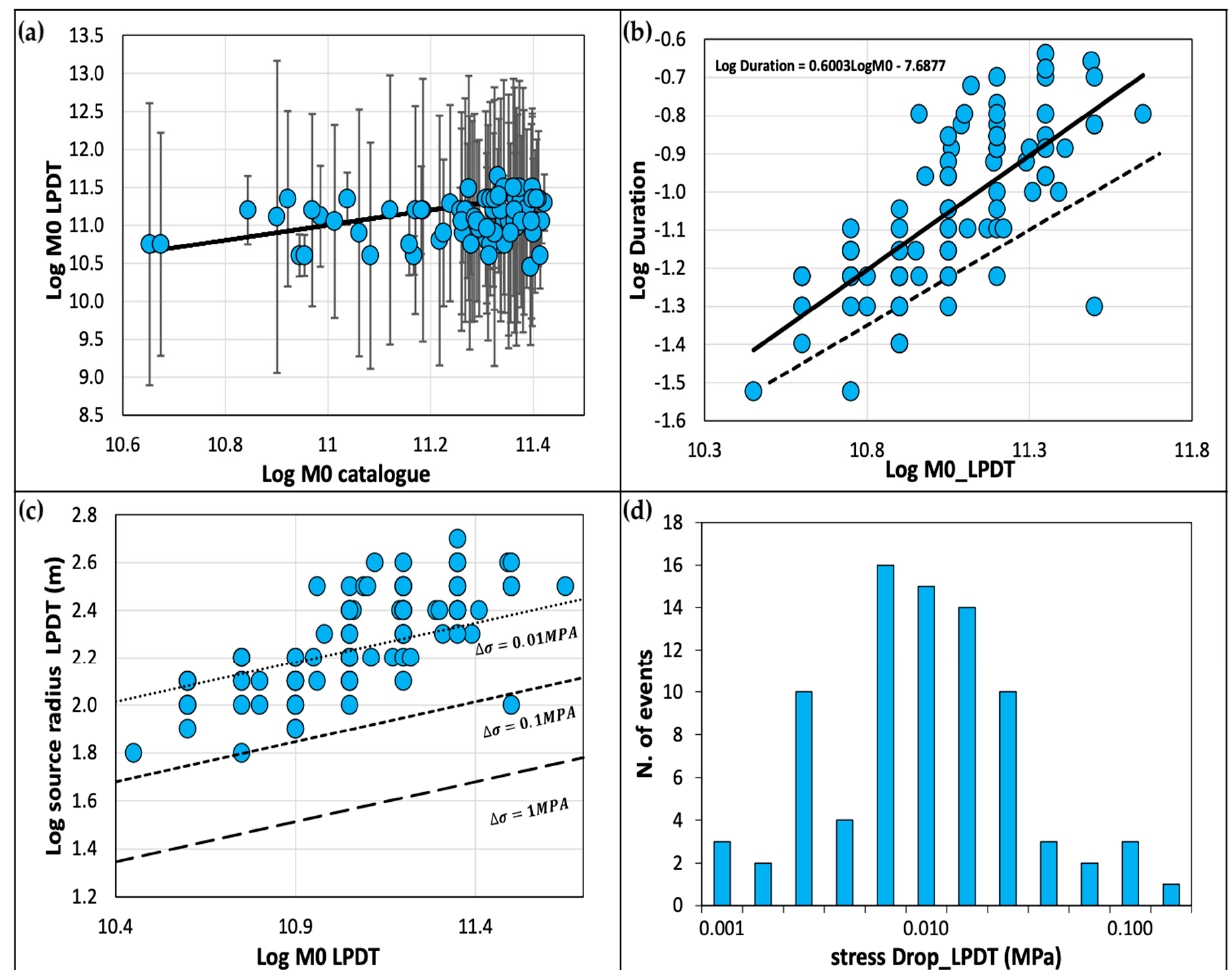
Figure 3. ( a ) Logarithm of seismic moments obtained from LPDT versus logarithm of seismic moments available from Kwiatek et al.’s refined catalogue. The solid black line represents the one-to-one relationship of catalogue M 0 . The errors are obtained by error propagation from T c and PL; ( b ) Logarithm of duration (inferred by T c of LPDT curves) versus logarithm of M 0 from LPDT. The solid black line of best fit is represented with its equation written in the top left corner of the panel; the dashed line represents the theoretical line with a slope value of 0.5 (see also Figure 4c [24]); ( c ) Logarithm of source radius versus logarithm of M 0 from LPDT. The data show a constant stress drop scaling with an average value of 0.01 MPa. Following different line styles, three different fixed values of constant stress drop are represented in the graph; ( d ) Stress release distribution obtained from LPDT. The mean stress release value is around 0.01